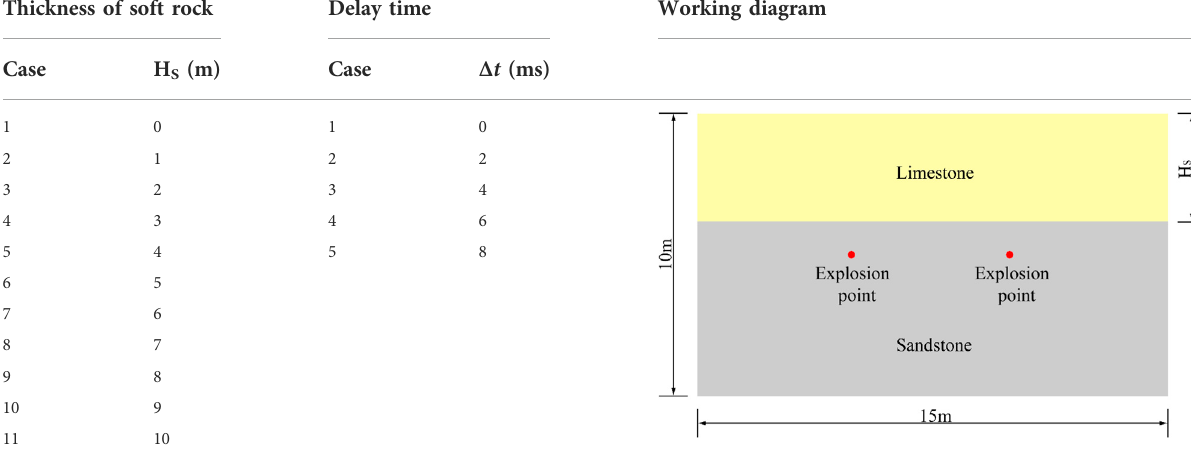
TABLE 4 Working cases of double-hole blasting.